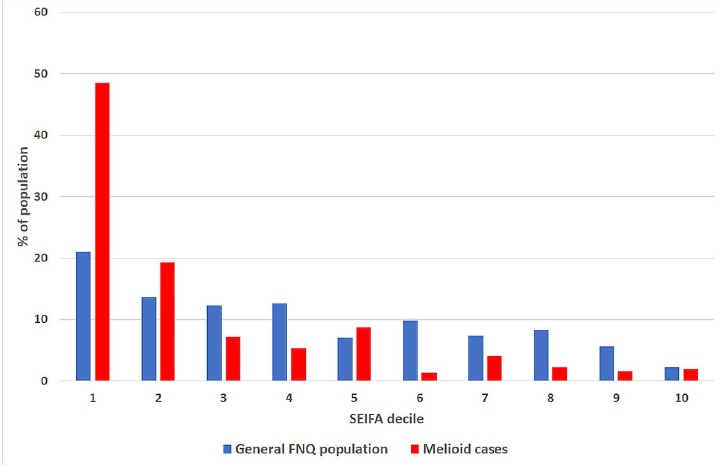
Fig 1. Socioeconomic disadvantage of people with melioidosis (determined using the SEIFA Index of Relative Socio-economic Disadvantage score) compared with the general FNQ population.